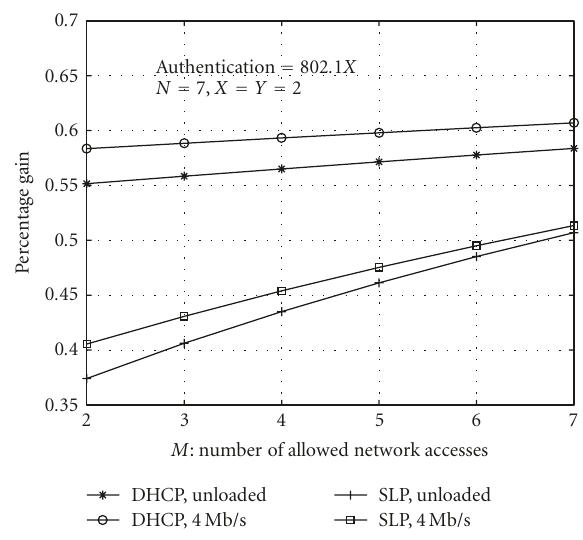
Figure 12: Percentage gain versus M : MAC-based authentication.